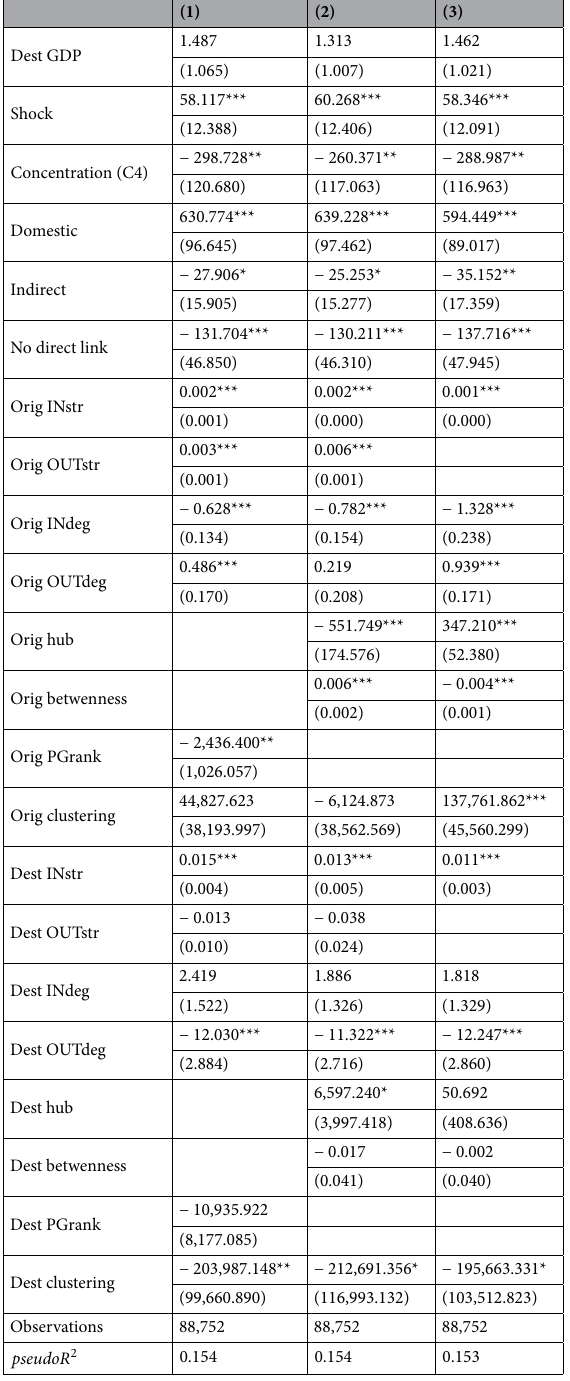
Table 5. Tobit regression: determinants of demand deficits (kcals/person/day). The table reports the detailed results of the Tobit regressions discussed in "Regression analysis". Dummies for α ∈ ( 0, 0.5, 1 ) not shown. Clustering and PageRank measures have been multiplied by 1,000. Robust standard errors in parentheses. Significance level: *** p < 0.01 , ** p < 0.05 , * p < 0.1